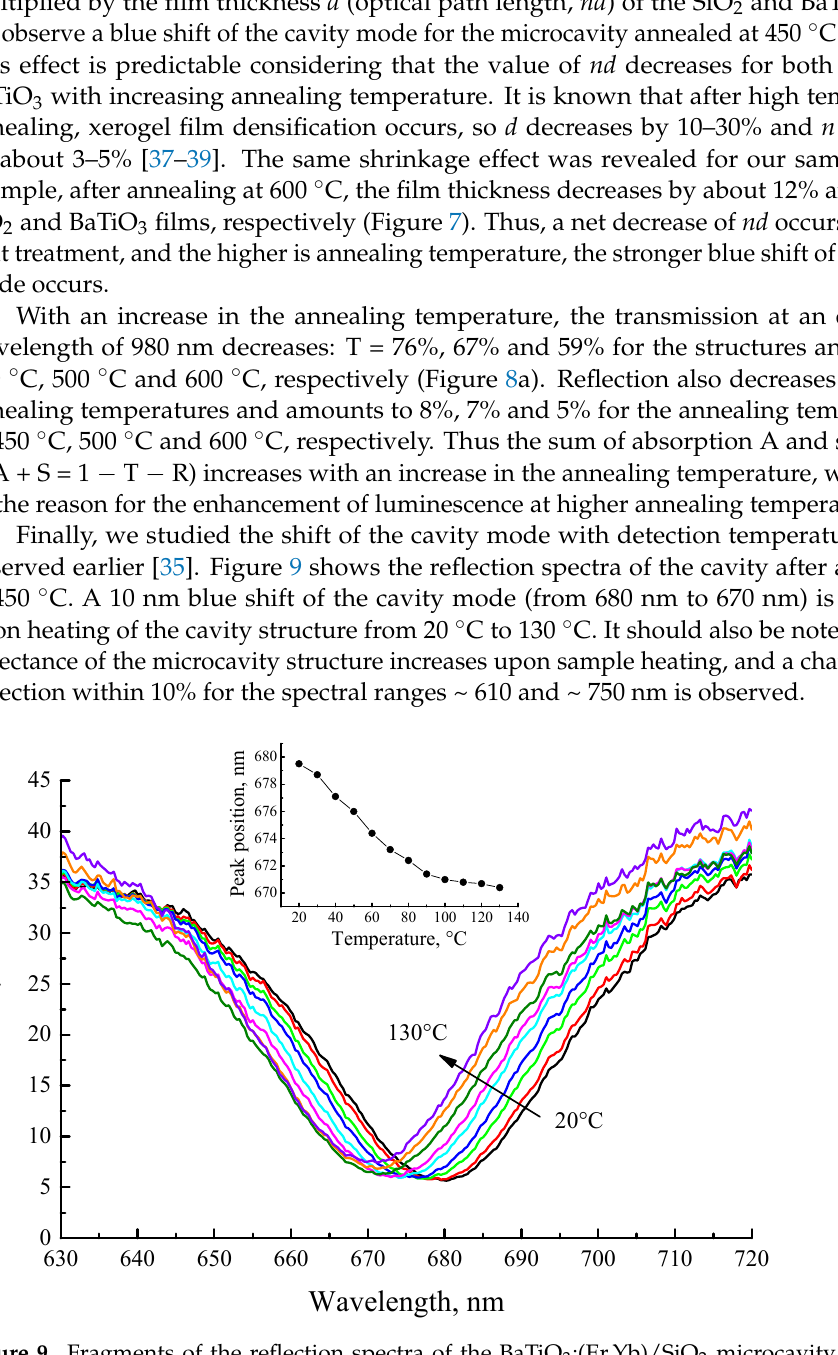
Figure 9. Fragments of the reflection spectra of the BaTiO 3 :(Er,Yb)/SiO 2 microcavity (sample F, annealed at 450 ◦ C) in the vicinity of the cavity mode, measured in the temperature range 20–130 ◦ C. Inset: central wavelength of the cavity mode as a function of temperature.